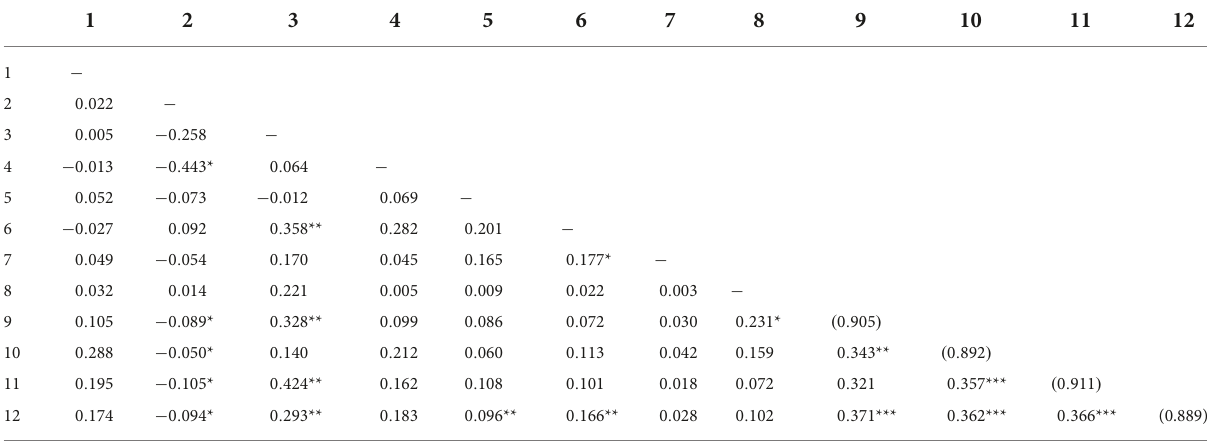
TABLE 4 Correlation coefficient matrix.